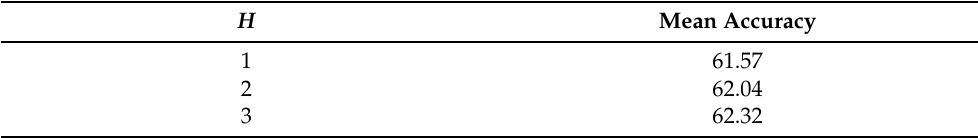
Table 4. The influence of hyperparameter H (number of images per review) on the model classification performance